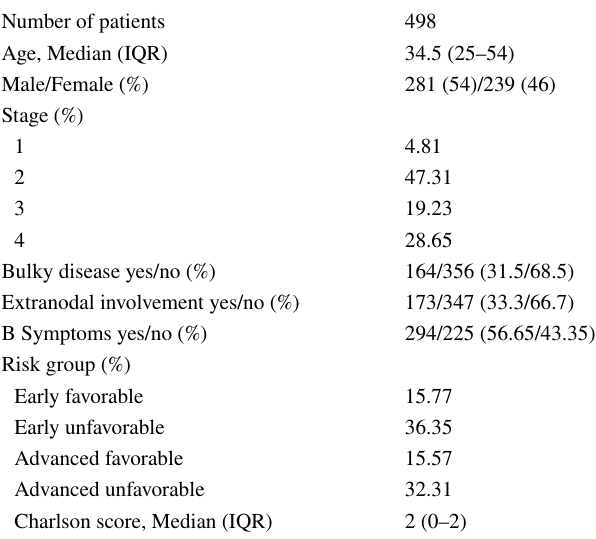
Table 1 Characteristics of patients diagnosed with Classical Hodgkin lymphoma (cHL) treated in first line Number of